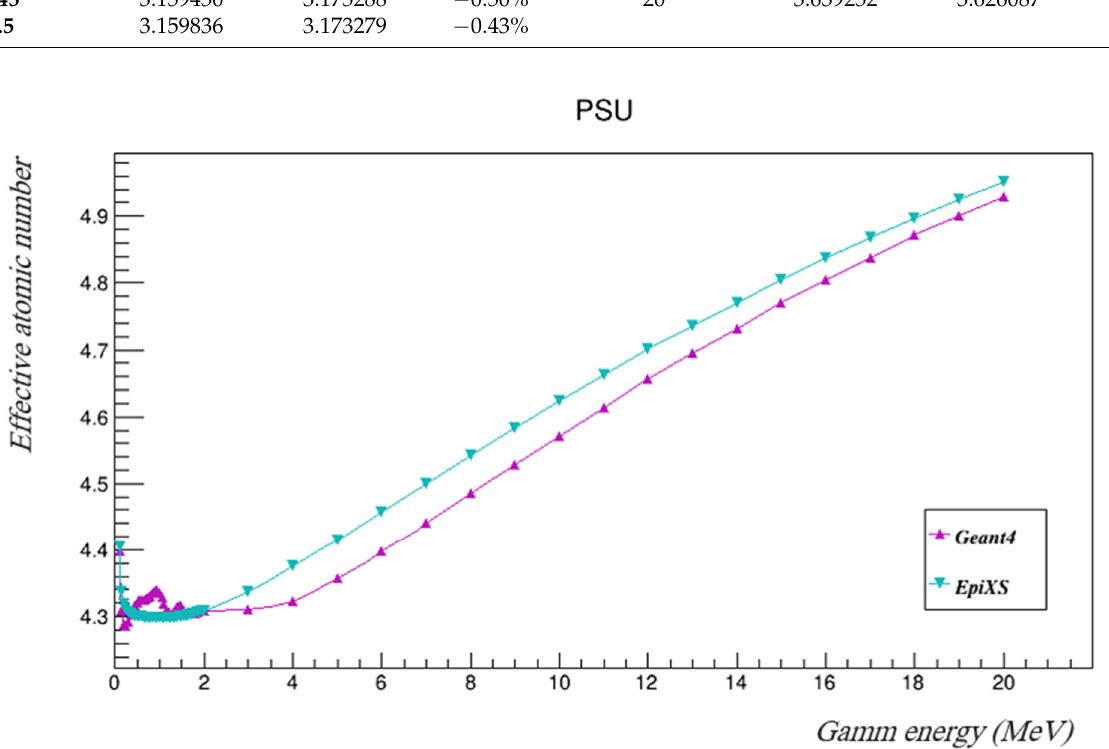
Figure 5. The effective atomic numbers of PSU with the investigated gamma energies using both Geant4 and EpiXS. Table 5. The electron effective densities of PSU in the investigated energy range.